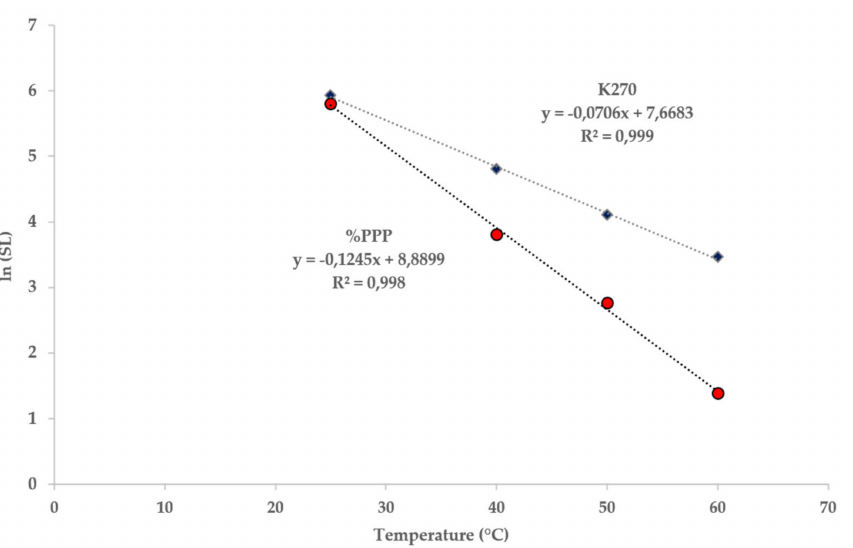
Figure 4. Shelf-life plots of EVOO by using K270 and %PPP as shelf-life